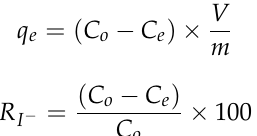
Figure 2. Standard calibration curve of I − .